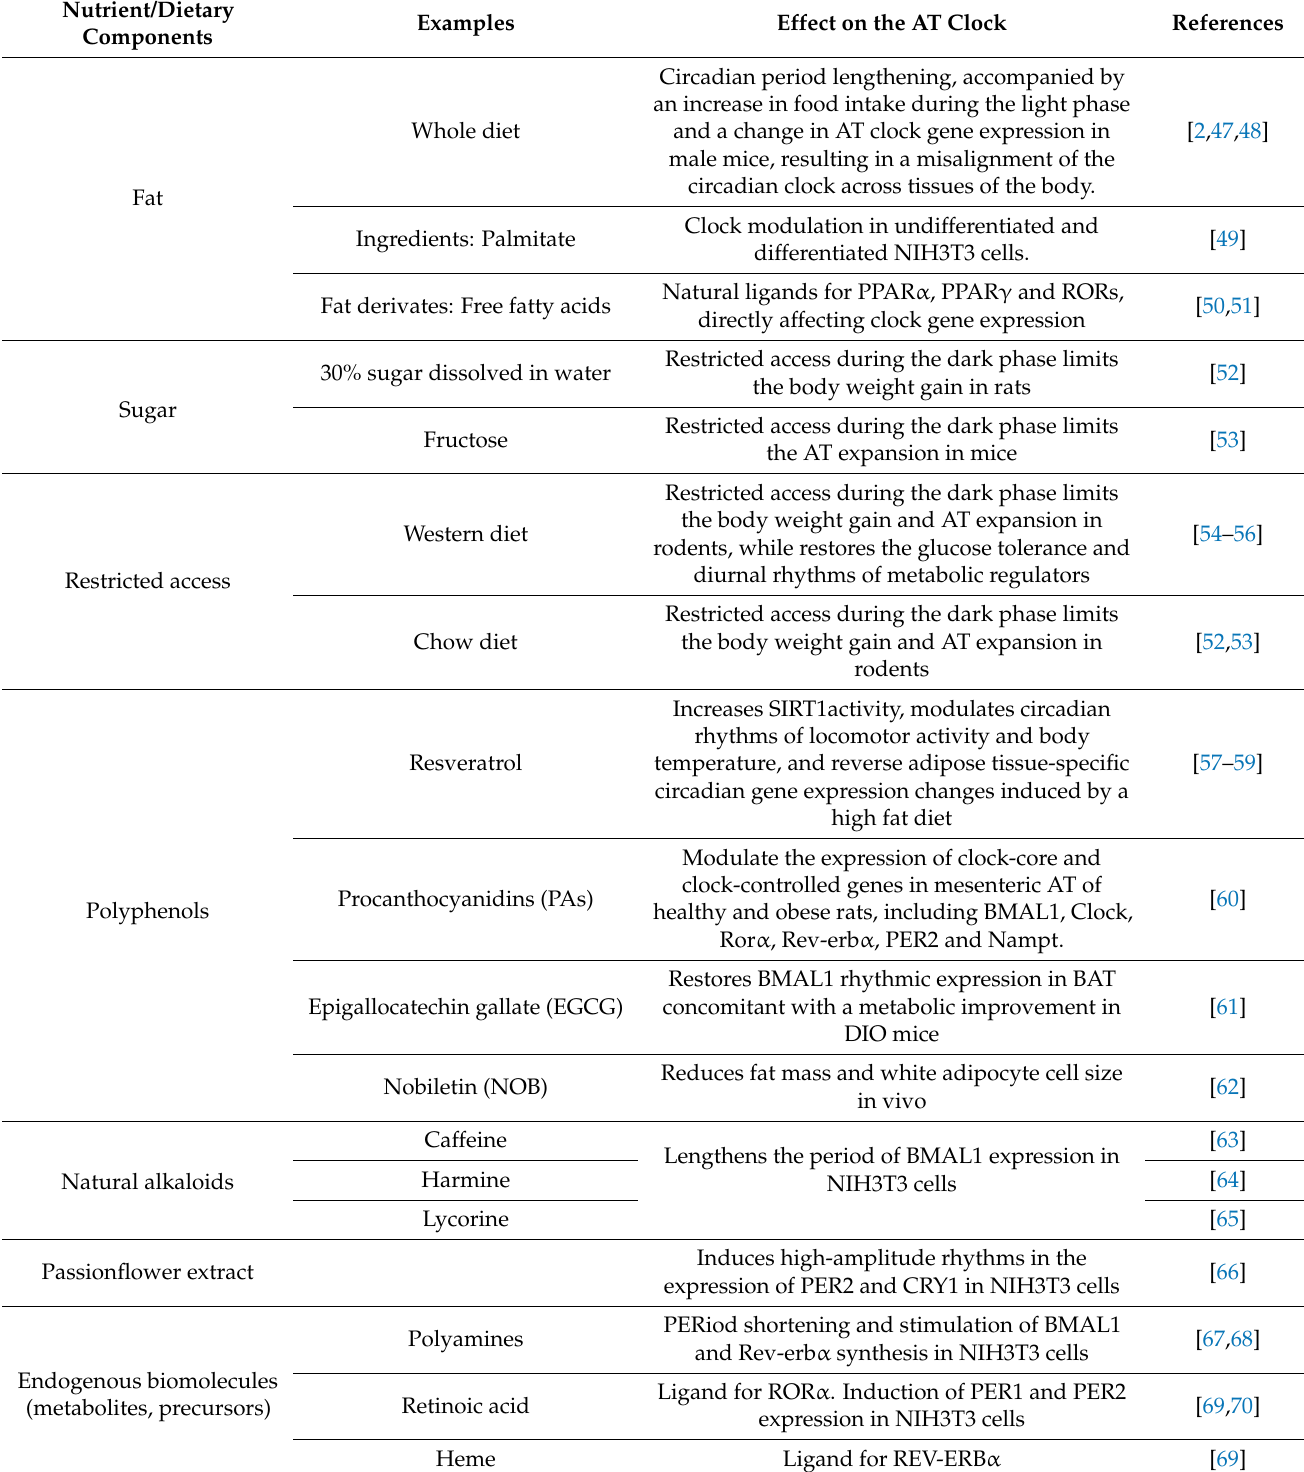
Table 1. Examples of nutrient components on the circadian clock across